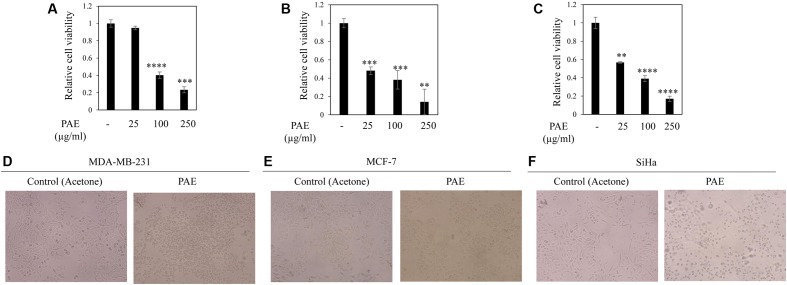
Effect of fruit pulp acetone extract of colocynth on cell viability and cytotoxicity of breast and cervical cancer cell lines. MTT assay was performed to measure cell viability by after 24 h of treatment of breast cancer MDA-MB-231 (A) and MCF-7 (B), and cervical SiHa (C) cell lines with pulp acetone extract (PAE) with different concentrations (25–250 μg/ml). Values represent mean ± SE of triplicate measurements, ∗∗p < 0.01, ∗∗∗p < 0.001, and ∗∗∗∗p < 0.0001, vs. control. (D–F) Morphologic visualization (cytotoxicity) was recorded after 24 h of treatment of breast cancer MDA-MB-231 (D) and MCF-7 (E), and cervical SiHa (F) cell lines with PAE (100 μg/ml). Photographs were taken at 10X magnification.